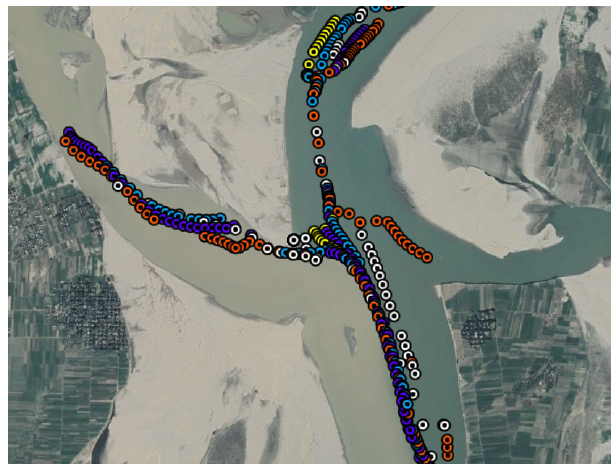
Figure 5. The location measurements for the different floaters (dif- ferent colors) at the confluence of the Chindwin and Ayeyarwady rivers. Both rivers stream north to south on this stretch with down- stream being the lower part of the figure (© Google Earth,